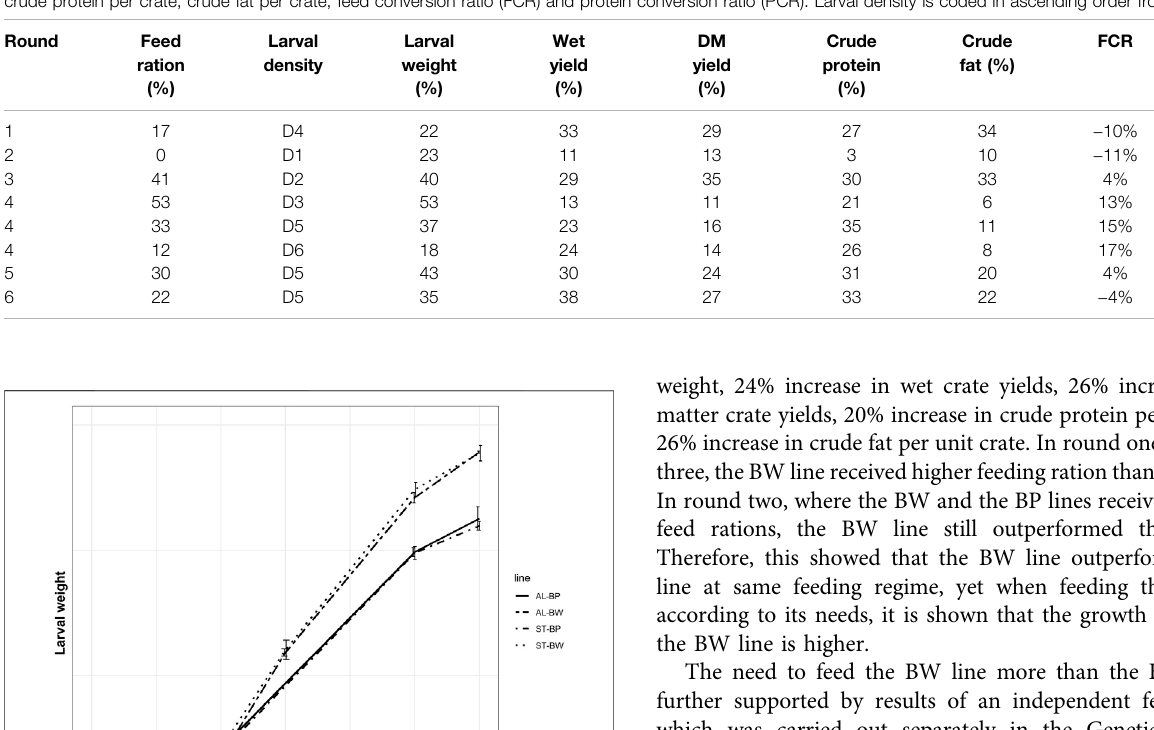
TABLE 2 | Descriptive statistics of performance differences between the Body weight line compared to the Base population line. The differences are expressed as percentage relative to the Base population line within round for feed ration (grams of feed per larva), average larval weight, wet crate yield, dry matter (DM) crate yield, crude protein per crate, crude fat per crate, feed conversion ratio (FCR) and protein conversion ratio (PCR). Larval density is coded in ascending order from D1 to D6.